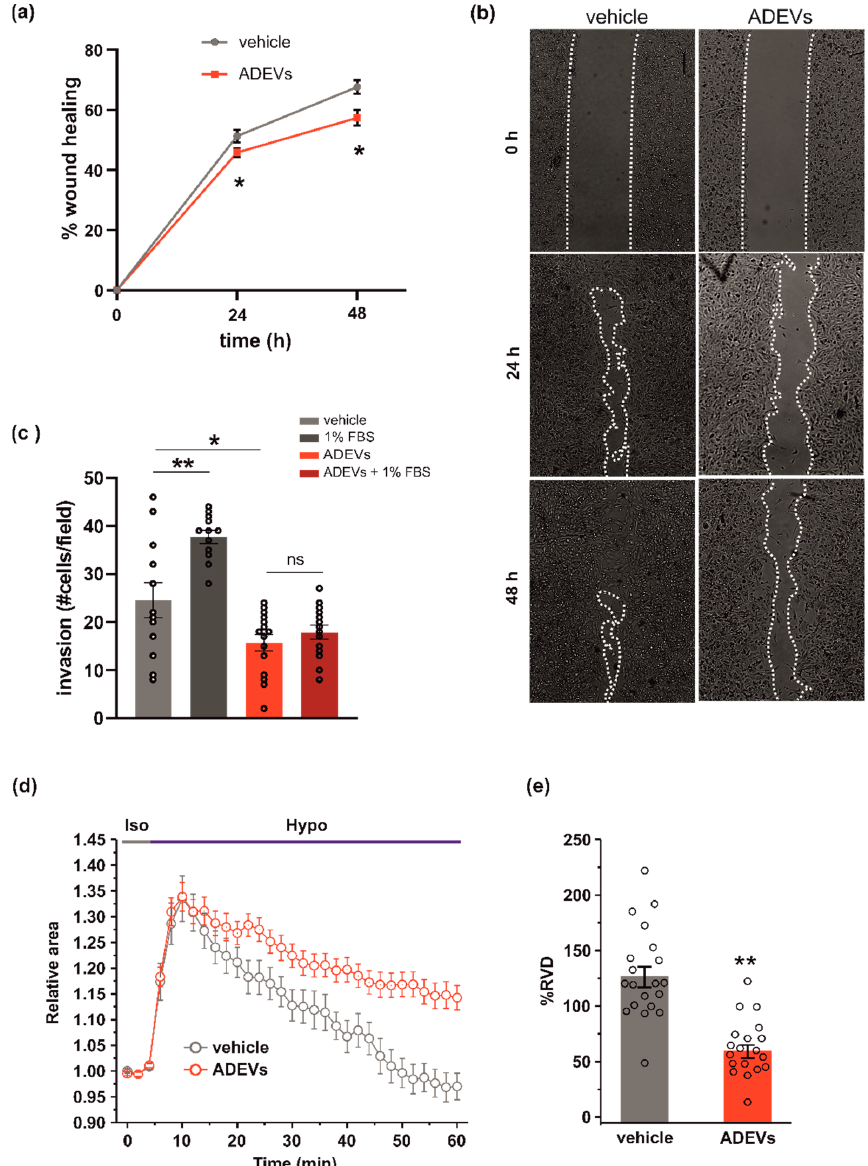
Figure 2. ADEVs limit glioma cell invasion. ( a ) GL261 glioma cells were treated with a sEV-free fraction medium (vehicle) or ADEVs, and a wound healing (migration) assay was performed. GL261 migration was measured 24 and 48 h after treatment, data are expressed as a mean percentage of wound healing area ± SE, N = 4, Student’s t-test, * p < 0.001. ( b ) Representative images of wound healing assay on GL261 cells treated as in ( a ). ( c ) GL261 cells were assayed for basal or FBS-induced invasion in vehicle- or ADEVs-treated cells on Matrigel. GL261 invasion was measured as a mean of invading cells/field ± SE, N = 3, at least 4 fields/condition; Student’s t-test, * p < 0.05 and ** p < 0.001 ( d ) Time course of RVD as evaluated from the changes of the relative cell area (Arel) in vehicle-treated cells (Iso, grey bar) and during the application of a 30% hypotonic solution (Hypo, blue bar) to GL261 vehicle-treated cells (vehicle, grey circles, n = 20) and to ADEVs-treated GL261 cells (ADEVs, red circles, n = 19). ( e ) Bar plot showing the average percentage of RVD in vehicle- and ADEVs-treated GL261 cells, calculated as follows: % RVD = (Arel,peak − Arel,56 min)/(Arel,peak)) × 100. Data are shown as mean ± SEM. Student’s t-test, ** p < 0.001.